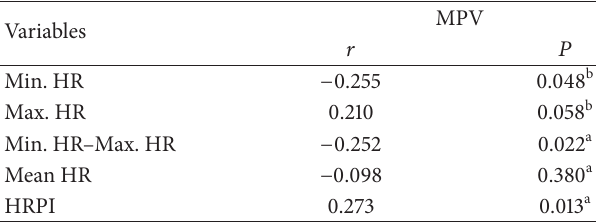
Table 3: Correlations between MPV and heart rate derivatives during polysomnography on the data of both